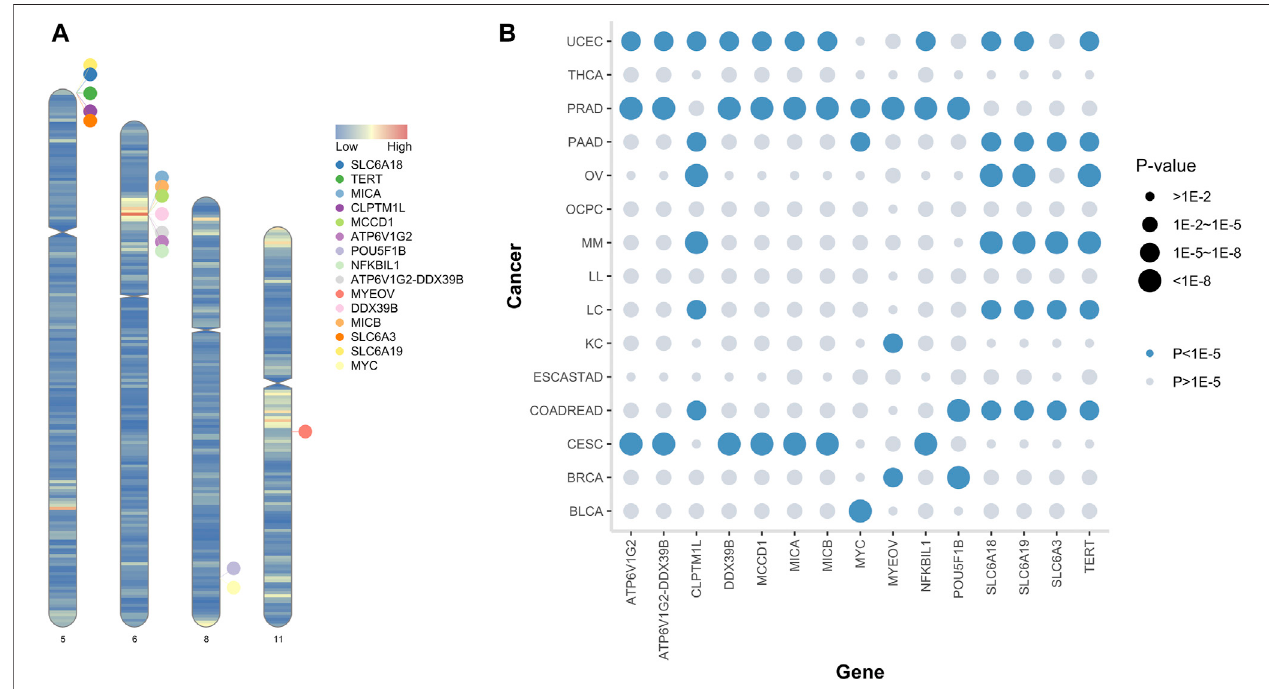
FIGURE 2 | Summary of the CAPER genes. (A) Ideogram of the 15 CAPER genes (the color of each chromosome indicates gene density across the human genome). (B) The bubble plot shows the minimum p -value of each causal gene in each cancer dataset.